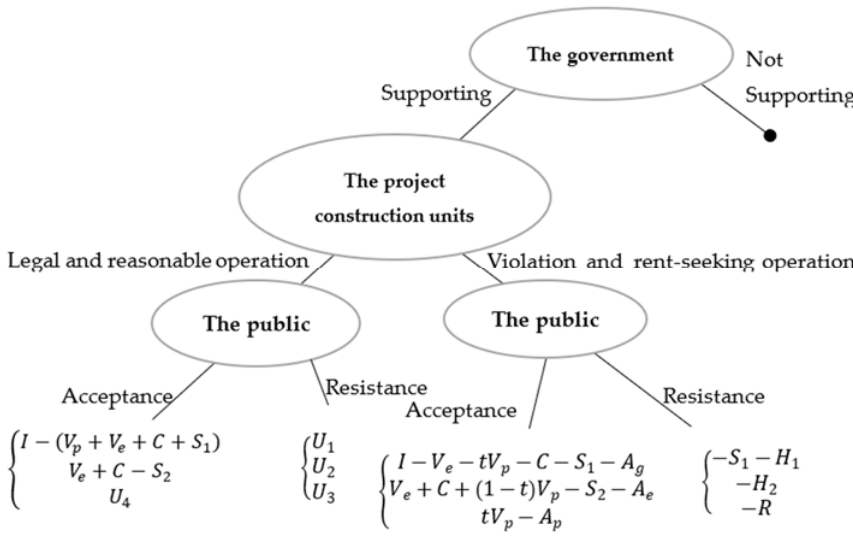
Figure 2. Three-agent three-stage dynamic game model based on the actual situation in China.